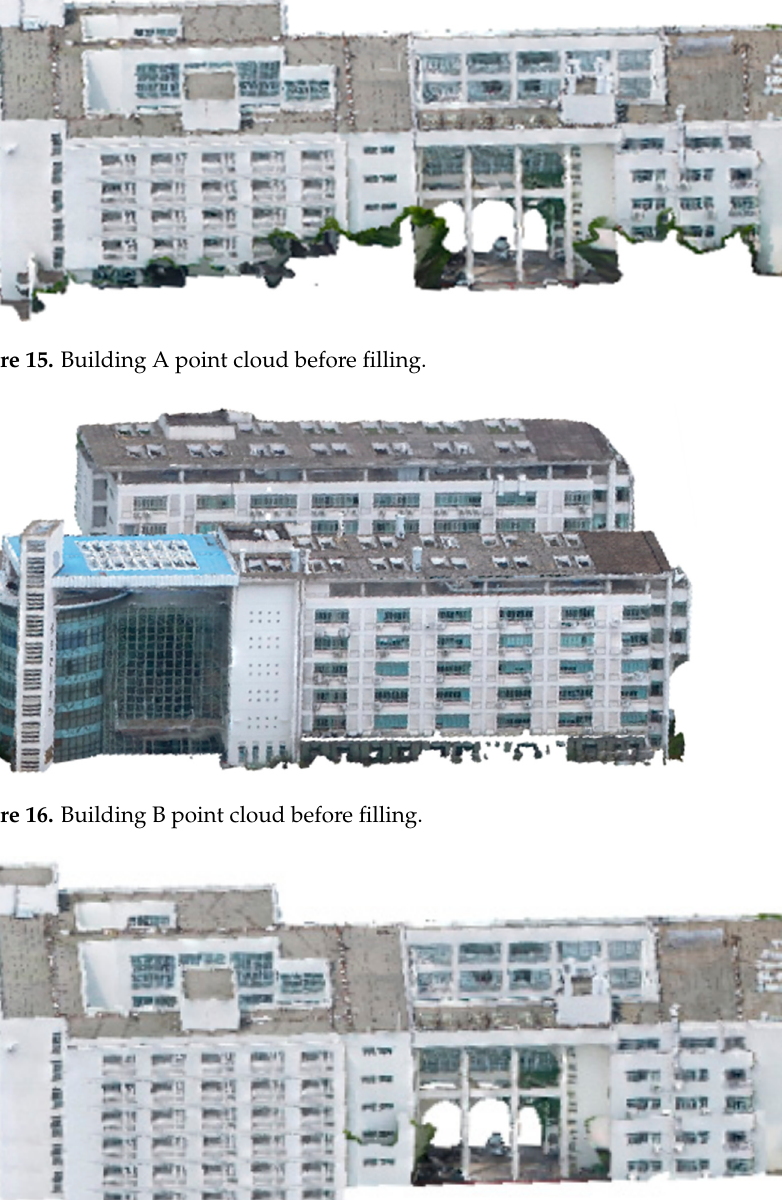
Figure 18. Filled results of building B by the proposed method.